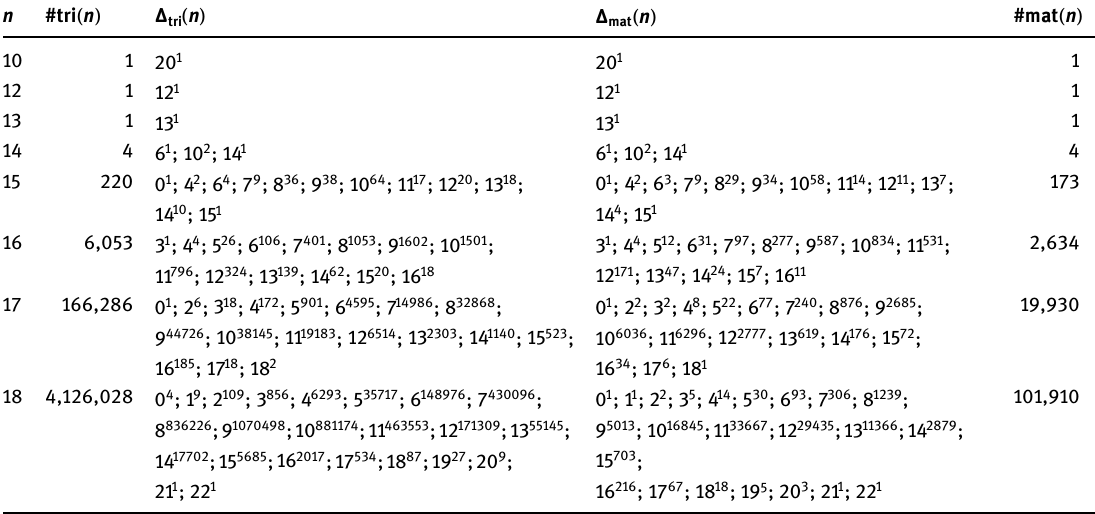
Table 2: Triangle distribution of n 3 - con fi gurations inducing triangular